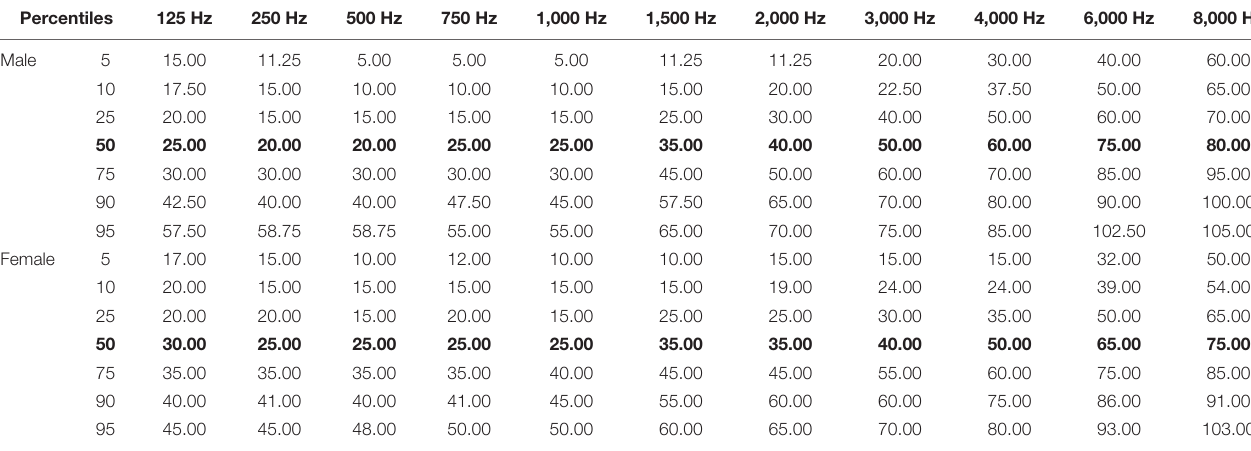
TABLE 3A | Reference values of hearing thresholds in senior adults of 80 years and older: percentile distribution of the air-conduction thresholds (dB HL) in the better hearing ear in males and females.